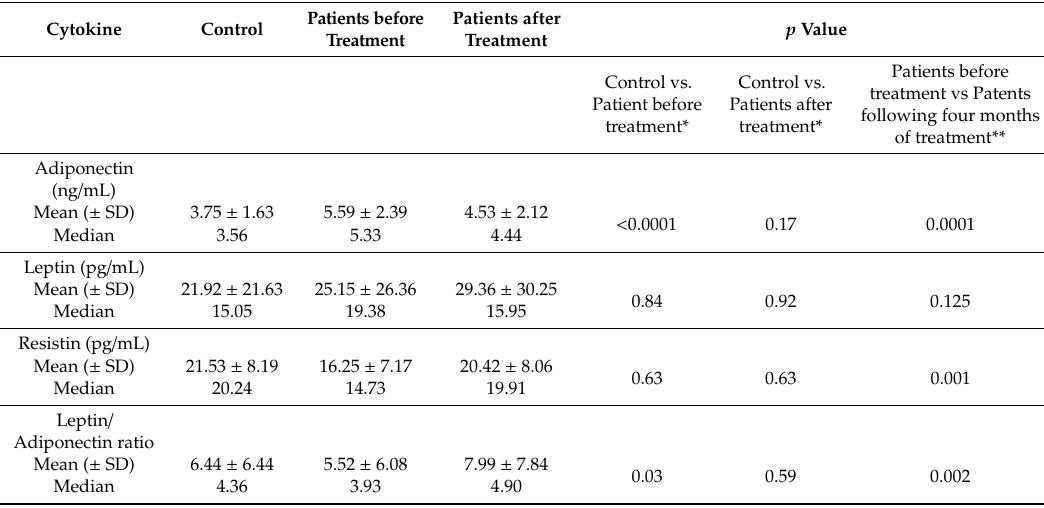
Table 3. Serum adipokine levels in healthy controls compared with RA patients before and after four months of tocilizumab (TCZ) treatment. Cytokine Control